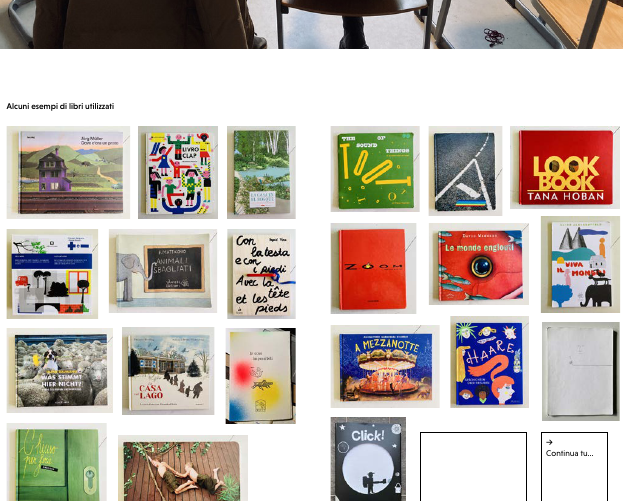
Fig. 2 Photo by Giulia